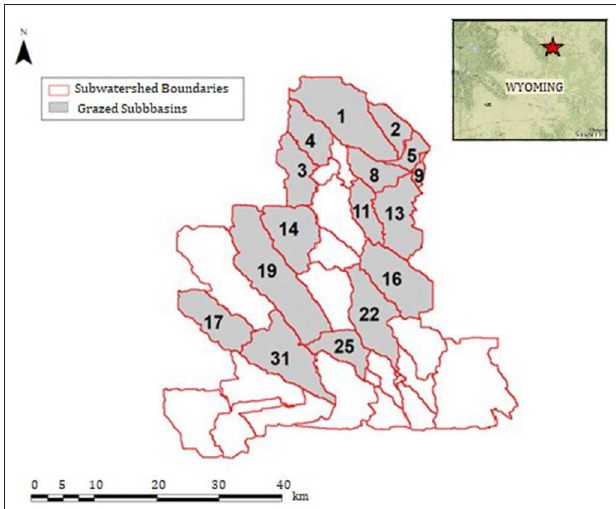
FIGURE 2 | Map of the grazed subbasins within the Ucross property used for setting up the rotational and continuous grazing